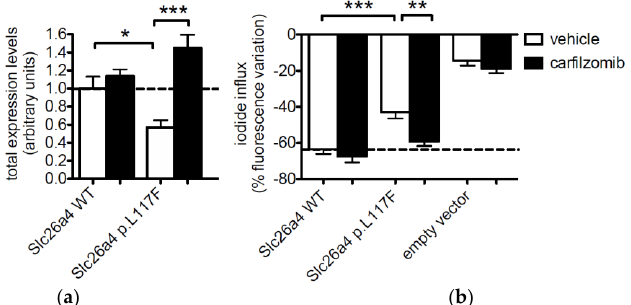
Figure 5. Expression and function of Mus musculus wild type pendrin and pendrin variant p.L117F in the presence of carfilzomib or its vehicle in HEK 293 Phoenix cells. ( a ) Cells were transfected with wild type (WT) or p.L117F SLC26A4 -EYFP for 48 h and incubated with 1 μM carfilzomib or the vehicle (0.01% DMSO) for 16 h. Protein expression levels are expressed as fluorescence intensity (levels of gray) normalized for the cell density. n = 20 imaging fields from 4 independent subcultures. ( b ) Cells were co-transfected with wild type (WT) or p.L117F SLC26A4 and the iodide sensor enhanced yellow fluorescent protein (EYFP) H148Q;I152L or EYFP H148Q;I152L alone (empty vector) for 48 h and incubated with carfilzomib or the vehicle for 16 h. The % decrease in fluorescence intensity indicates an iodide influx from the bath solution towards the intracellular environment. n = 24 measurements from 4 independent experiments. * p < 0.05, ** p < 0.01, *** p < 0.001, one-way ANOVA with Bonferroni’s multiple comparison